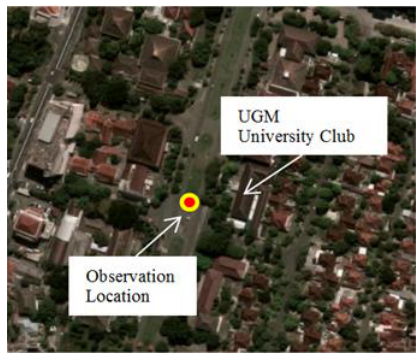
Fig. 7. Dual frequency equipments used in the experiment; (a) antenna Tersus AX3702, (b) receiver Tersus BX305 The experiment was done in the Campus of Universitas Gadjah Mada (UGM). The open sky experiment was done on zero order national pillar N0005 located on the west side of UGM University Club Building (Fig. 8) while the obstructed experiment was done on mapping bench mark (BM) on the north side of Geodetic Engineering Department (Fig. 9).